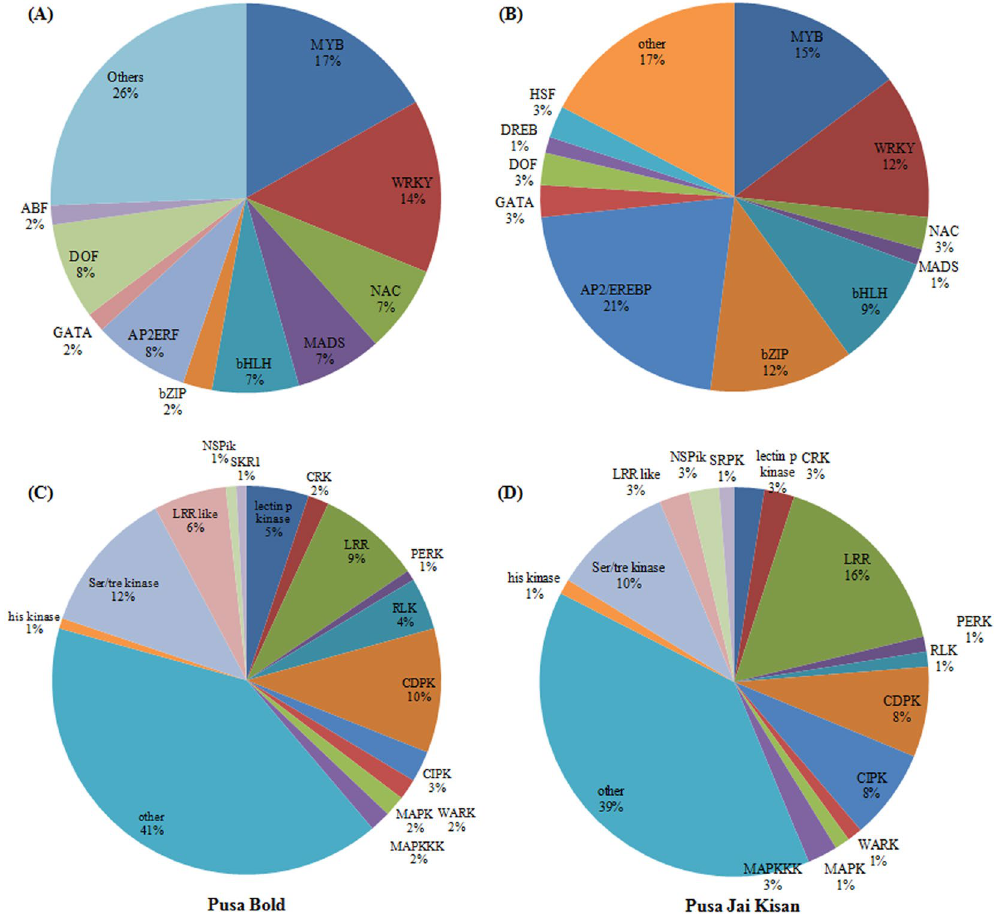
Figure 3. Plot showing transcription factor families ( A , B ) and protein kinases ( C , D ) found to be induced in response to early (20 min) low nitrate treatment (0.25 mM KNO 3 ) in PB and PJK on the basis of their transcript